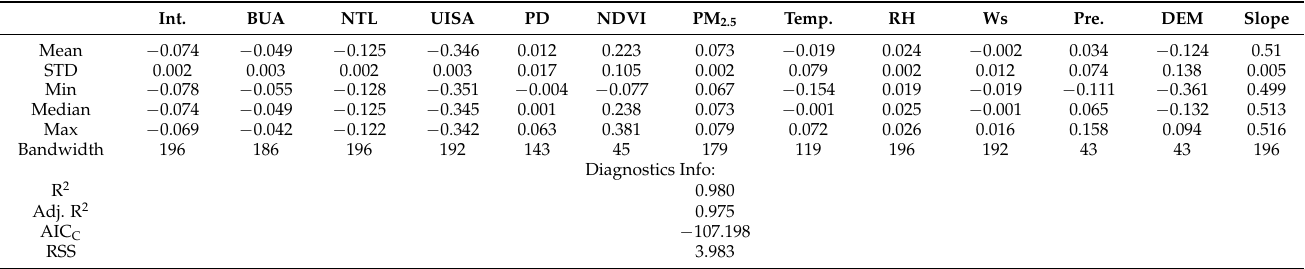
Table 5. Results of the MGWR model between carbon storage and drivers in